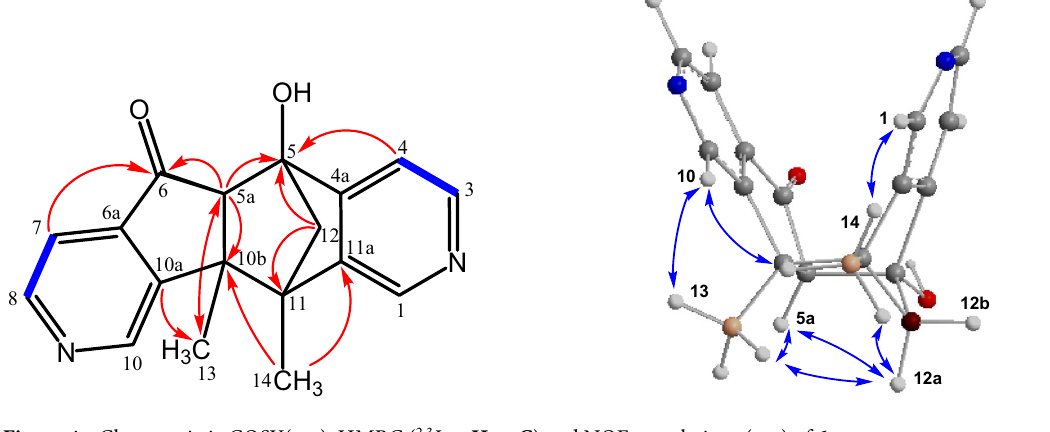
Compound 5 : (5a R *,6 S* ,7a R* ,8 S* ,11a R* )-10-Hydroxy-7a,11a-dimethyl-5a,6,7,7a,8,11a-hexahydro-5 H -6,8- epoxycyclopenta[6,7]azuleno[1,2- c ] pyridin-5-one.